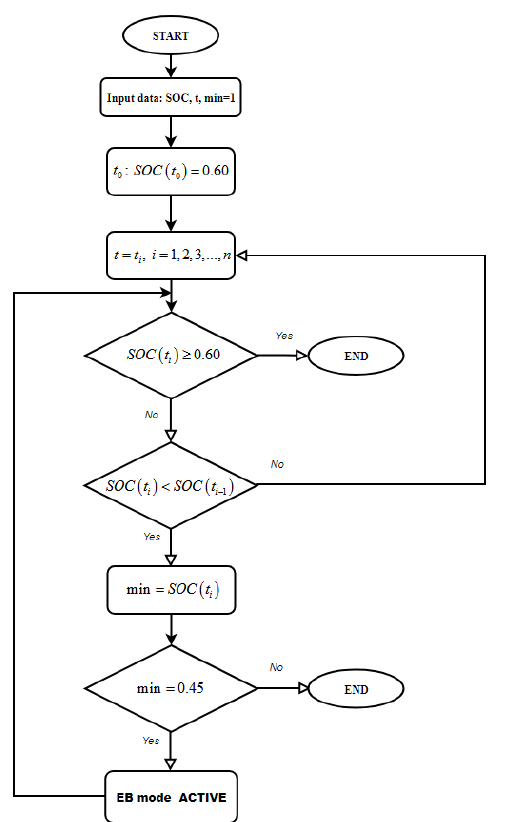
Figure 6. EB operating mode algorithm